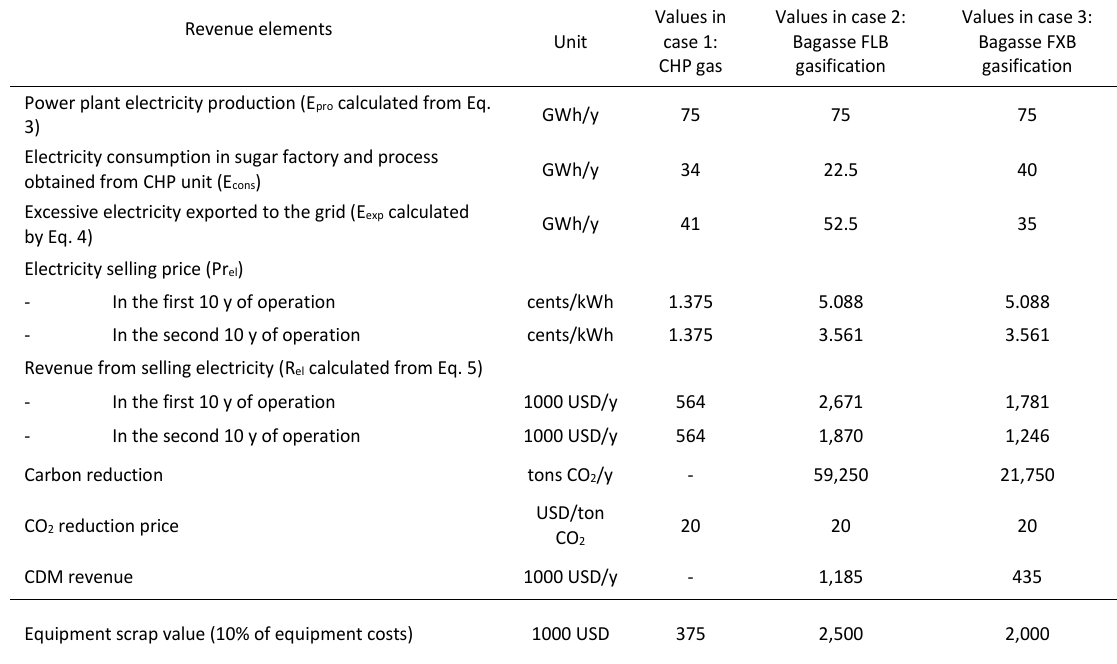
Table 4: Revenues estimated for 10-MW power plants in the studied cases Revenue elements Unit